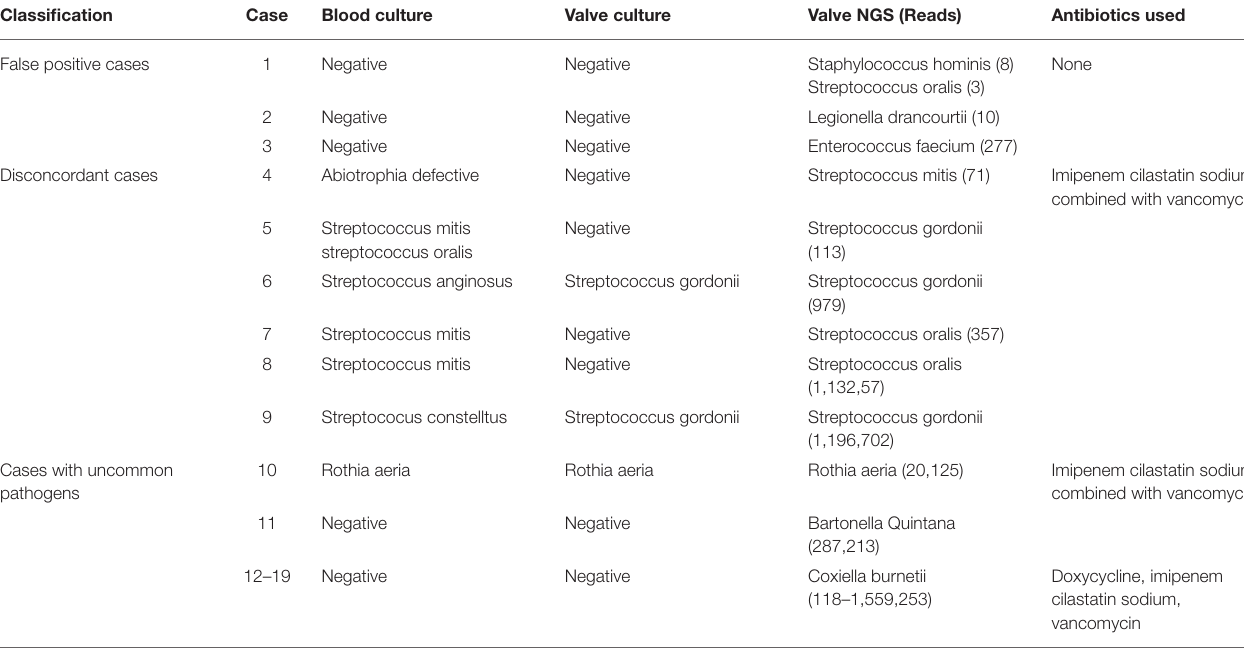
TABLE 4 | Summary of representative cases identified in valve